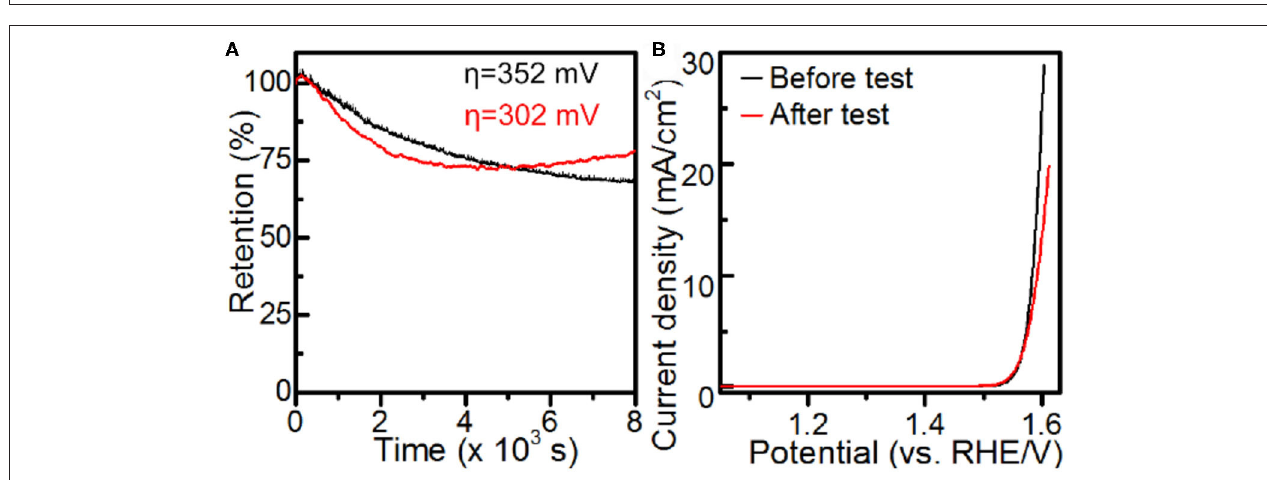
FIGURE 4 | Electrochemical measurements in 1M KOH: (A) chronoamperometry and (B) iR-corrected LSV using Co-MOF nanosheets.